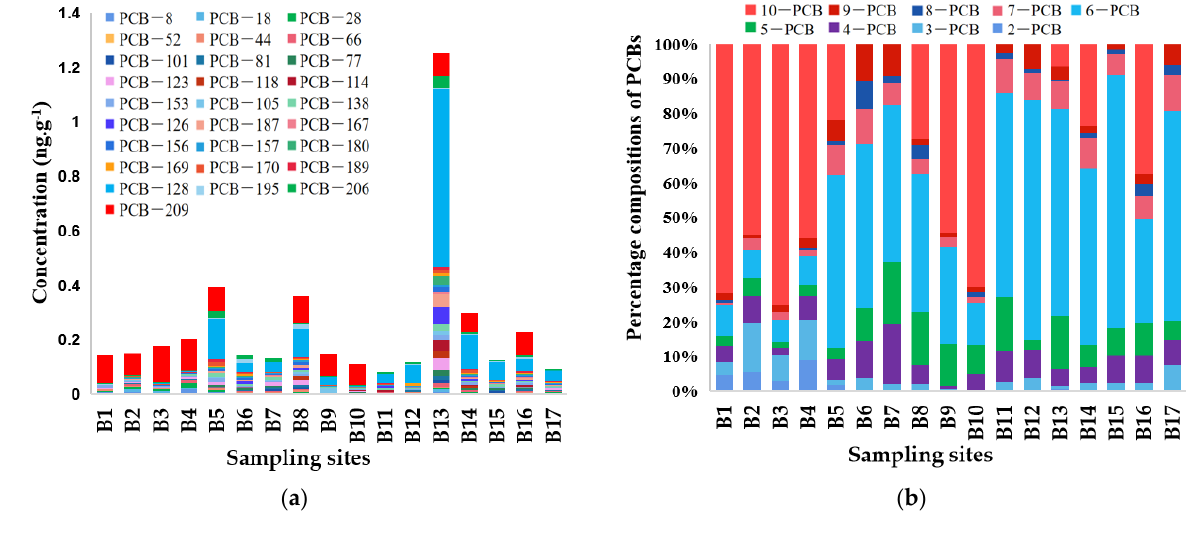
Figure 2. ( a ) PCBs concentrations in sediment sampling points ( b ) Contribution of PCBS homologous spectral concentrations. Table 1. Comparisons of PCBs (ng · g − 1 · DW) in sediments from different